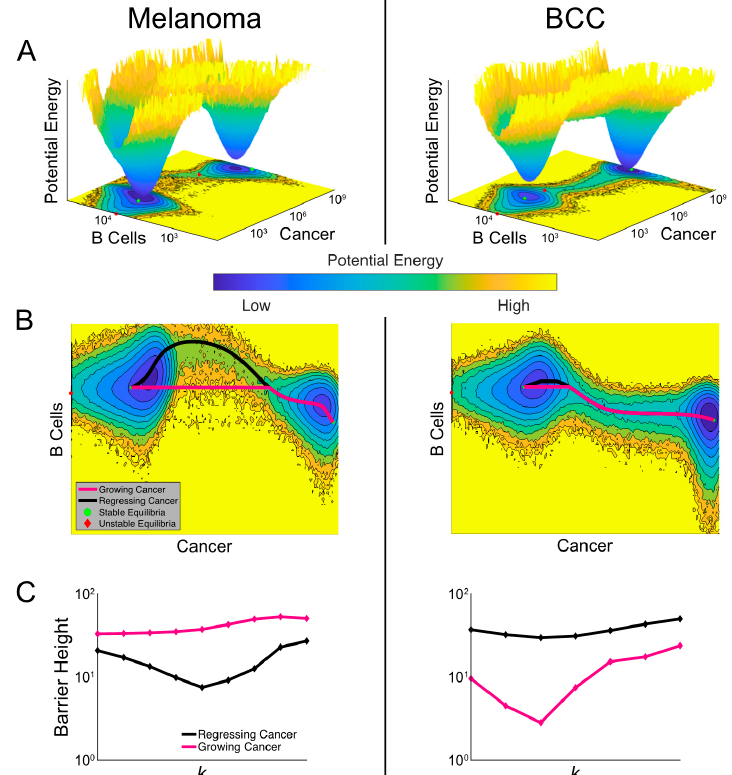
Figure 6. Comparisons of landscapes and transition paths for melanoma and BCC potentially explain the refractory response to checkpoint therapy in BCC. ( A ) Cancer-state energy landscape of both cancers with k = 1.8 × 10 − 4 and d e = 1. Lower values indicate a higher probability of finding the system in that state. These values represent marginal potential energies, having marginalized over macrophages. A contour plot is shown below along with the ordinary di ff erential equation (ODE)-determined equilibria, both stable (green dots) and unstable (red diamonds). ( B ) The transition paths between the stable equilibria plotted over the contour plots from ( A ). The black path is for regressing cancer and the magenta path is for growing cancer. ( C ) The barrier height between the two high-burden and low-burden cancer states as it varies with the killing rate k. The black curve shows the variation of the barrier height for regressing cancer and the magenta for growing cancer.